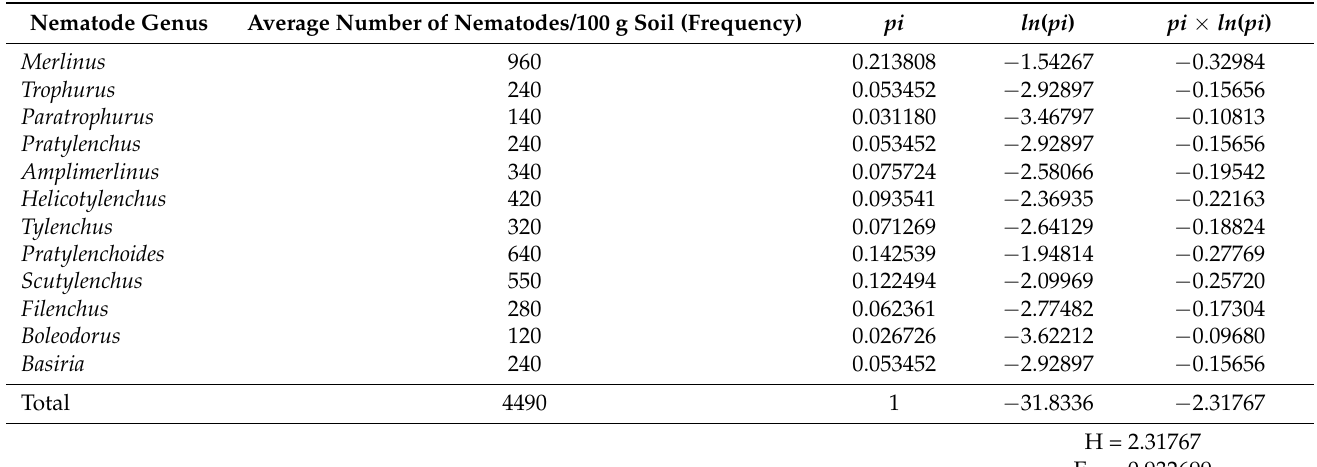
Table 7. Diversity of migratory nematodes in wheat field using Shannon diversity index.